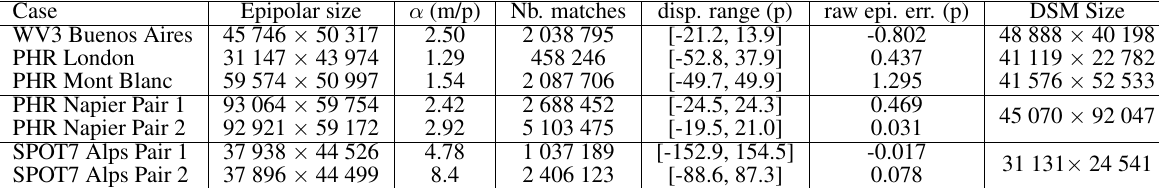
Table 2. Main parameters estimated during pipeline execution. Collection of 3 images are processed by forming to pairs and merging them during DSM computation step. Number of matches is the raw number of matches found before filtering. Epipolar error is the mean epipolar error before correction (value after correction is not given, since it is always almost zero) time changes according to input images size, number of pairs